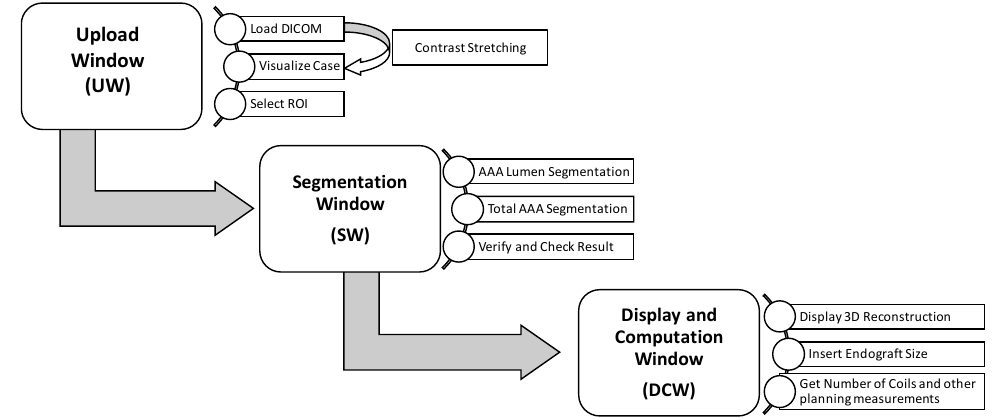
Figure 1. EVAR-eaSE framework: the three interconnected processing modules (Upload Window—UW, Segmentation Window—SW, Display and Computation Window—DCW) and the main software functions implemented in each module.